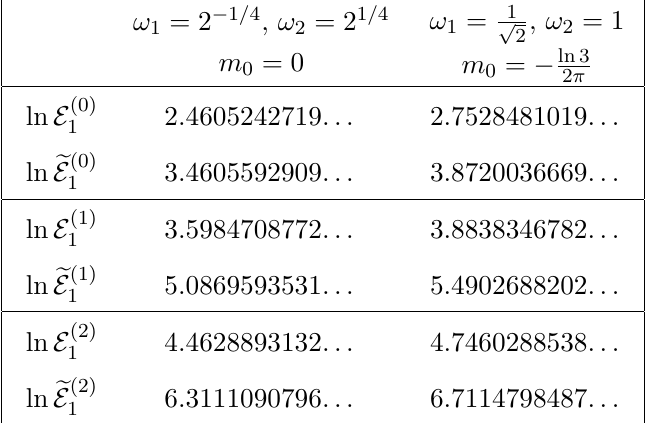
, e E ( n ) of (3.23) at level n = 0 ; 1 ; 1 1